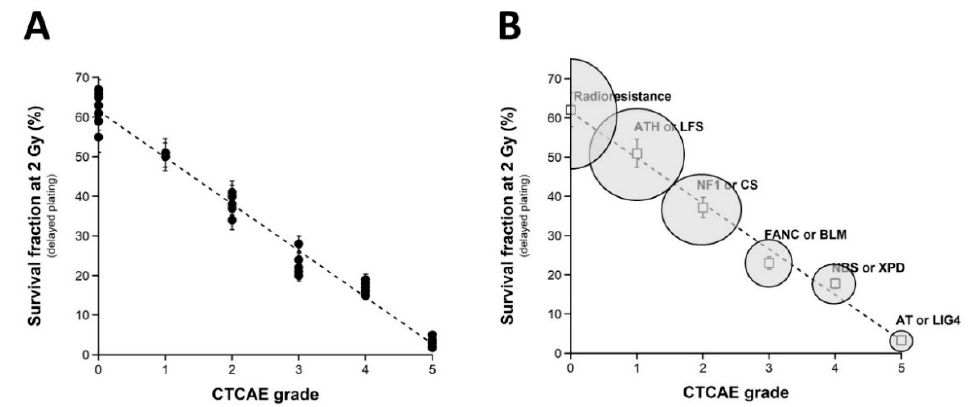
Figure 1. Clonogenic cell survival vs. CTCAE grades. ( A ) The SF2 data from 36 COPERNIC cell lines were plotted against the corresponding CTCAE grade values (closed circles). Each point corresponds to the mean ± standard error of the mean (SEM) of three independent triplicates, at least. The best data fit was obtained with the linear law: SF2 (%) = 61.55 − 11.72 × grade; r 2 = 0.98 (dotted line). ( B ) The average SF2 values ( ± SEM) of the data shown in Fig1A were plotted against the corresponding CTCAE grade (open squares). The dotted line is the reproduction of the data fit shown in ( A ). An arbitrary 25% relative error was applied to the SF2 and grade values. The resulting 25% confidence circle zones were built in grey. They schematically reproduce the average SF2 values observed from fibroblasts deriving from patients suffering from the indicated syndromes (AT: ataxia telangiectasia, homozygous mutations of ATM ; LIG4: homozygous mutations of LIG4 ; NBS: Nijmegen’s syndrome, homozygous mutations of NBS1 ; XPD, xeroderma pigmentosum D, homozygous mutations of XPD ; BLM, Bloom’s syndrome, homozygous mutations of BLM ; FANC, Fanconi anemia, homozygous mutations of FANC ; NF1, neurofibromatosis type 1, heterozygous mutations of neurofibromin; CS, Cockayne’s syndrome, homozygous mutations of CS ; LFS: Li-Fraumeni’s syndrome, heterozygous mutations of p53; ATH, heterozygous mutations of ATM . The syndromes data were obtained from our lab and published elsewhere [3,15].